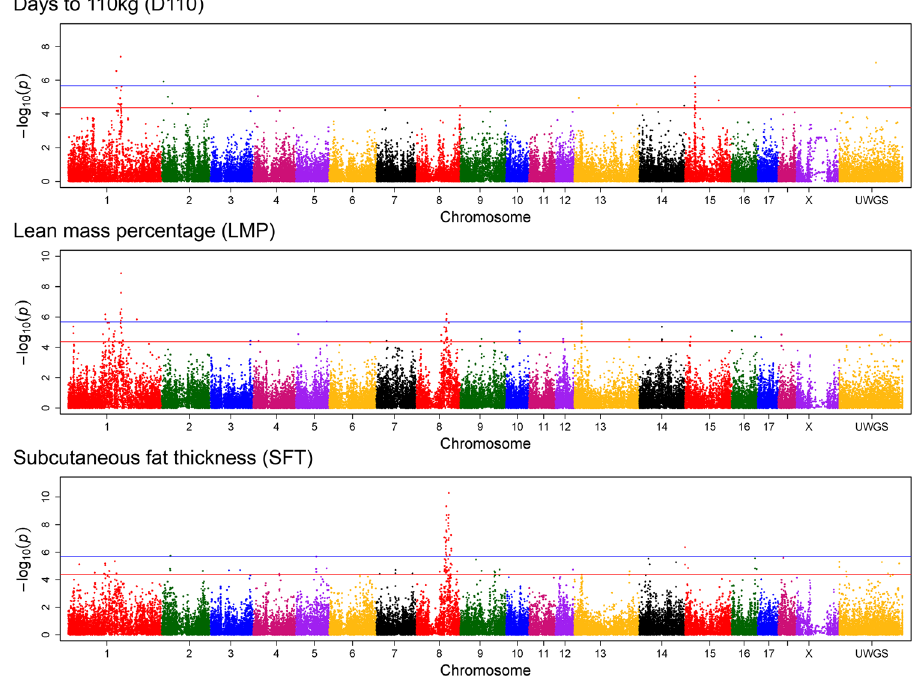
Figure 1. Manhattan plots of genome-wide association analysis results for traits related to body fat mass using a single marker (mixed linear model) approach. Chromosome ‘UWGS’ represents a contig of unmapped markers. The threshold for suggestive and genome-wide significance was set to p = 4.3e-05 (equals to -log 10 (p- value) = 4.37) and p = 2.1e-06 (equals to -log 10 (p-value) = 5.67), respectively.